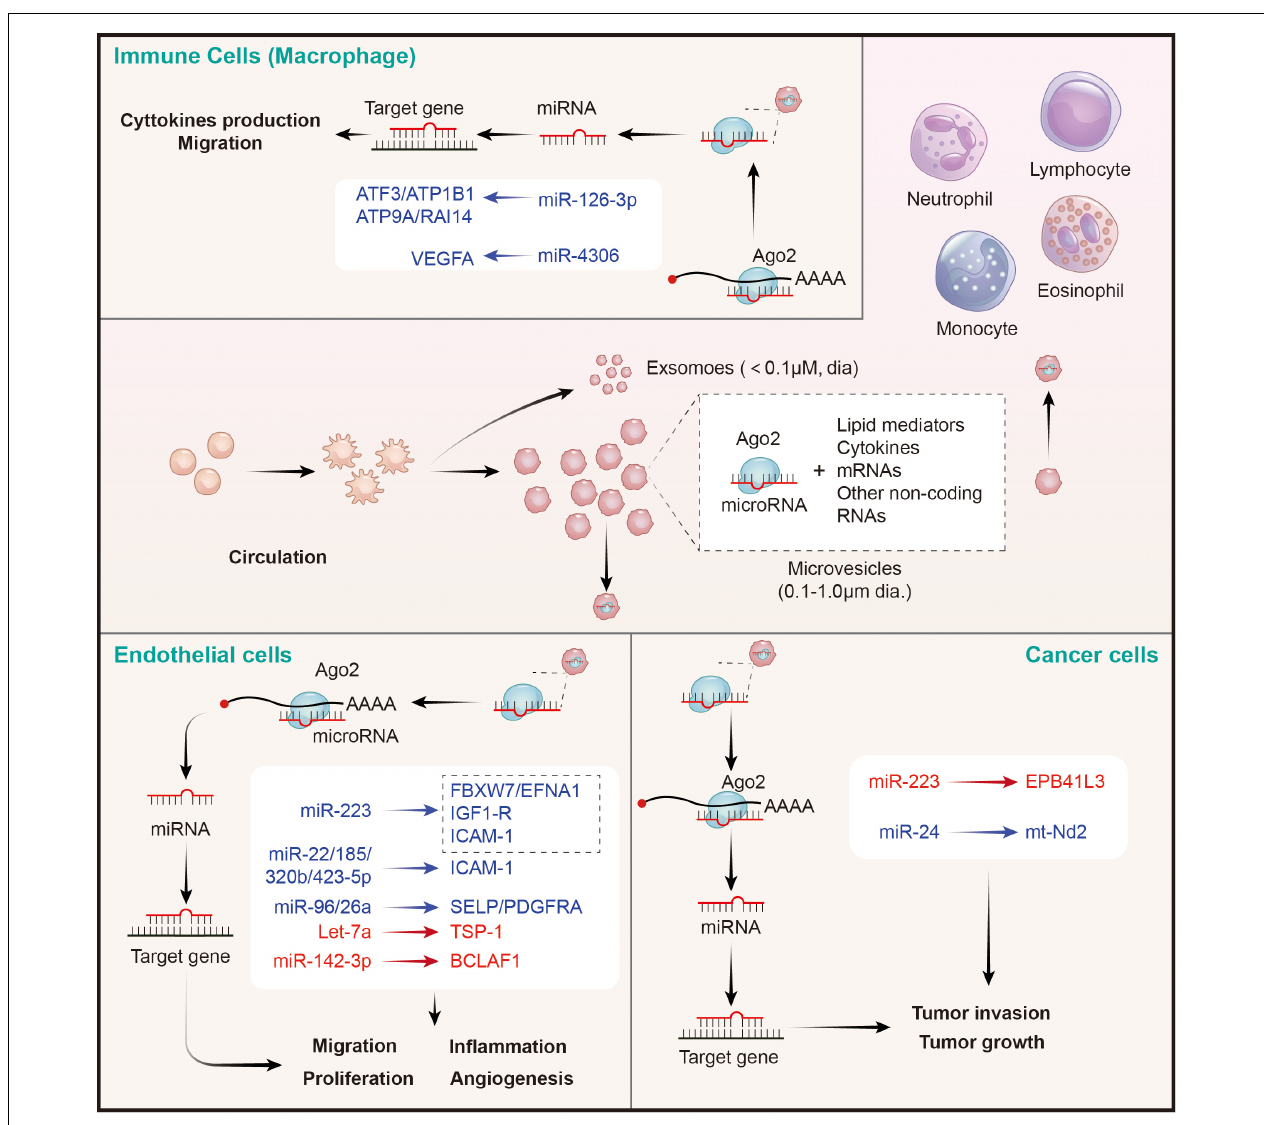
FIGURE 3 | Platelet MPs mediate the transfer of intercellular miRNAs to other cells in the circulatory system, and participate in the regulation of gene expression of recipient cells. MPs released by activated platelets are rich in bioactive lipid mediators, cytokines, mRNAs and a wide variety of non-coding RNAs (including miRNAs). Platelets derived miRNAs can be efficiently transferred into endothelial cells, immune cells, and cancer cells through MPs-mediated manner. Platelet MPs form a tent to protect miRNAs from extracellular nucleases degradation and act as intercellular transporters to deliver functional Ago2 · microRNA complexes, through which they modulate the genes of recipient cells in the circulatory system and perform a wide range of biological functions. The red represents miRNA-mRNA pairs that produce promoting functions and the blue represents miRNA-mRNA pairs that produce inhibitory functions. Abbreviations: Ago2, argonaute 2; ATF3, activating transcription factor 3; ATP1B1, sodium/potassium-transporting ATPase subunit beta-1; ATP9A, ATPase phospholipid transporting 9A; RAI14, retinoic acid induced 14; VEGFA, vascular endothelial growth factor A; FBXW7, F-box and WD-40 domain protein 7; EFNA1, ephrin A1; IGF1-R, insulin like growth factor 1 receptor; ICAM-1, intercellular adhesion molecule 1; SELP, selectin P; PDGFRA, platelet derived growth factor receptor alpha; TSP-1, thrombospondin 1; BCLAF1, BCL2 associated transcription factor 1; EPB41L3, erythrocyte membrane protein band 4.1 like 3; mt-Nd2, mitochondrially encoded NADH: ubiquinone oxidoreductase core subunit